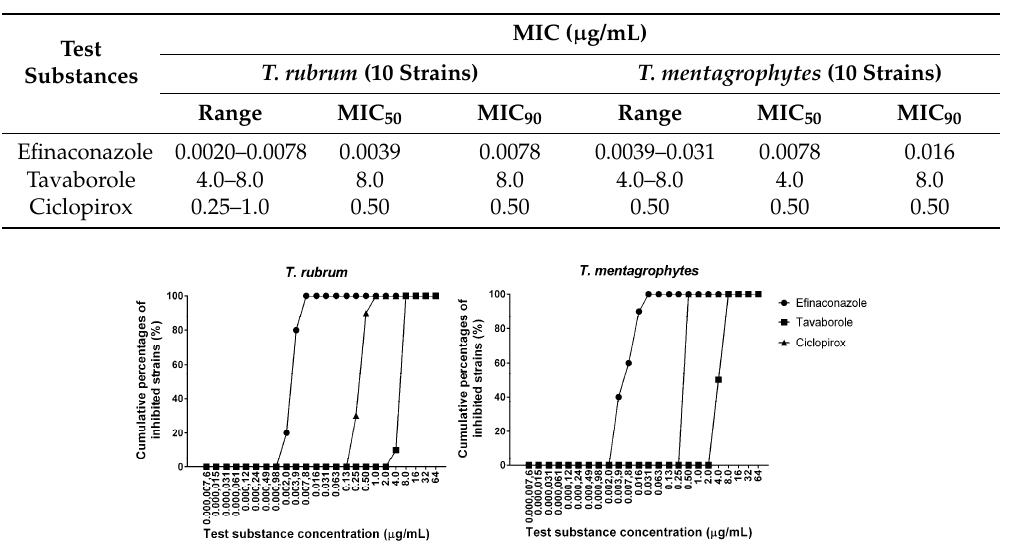
Figure 2. Cumulative MIC frequency distribution of efinaconazole, tavaborole, and ciclopirox for T. rubrum and T. mentagrophytes (each 10 strain).